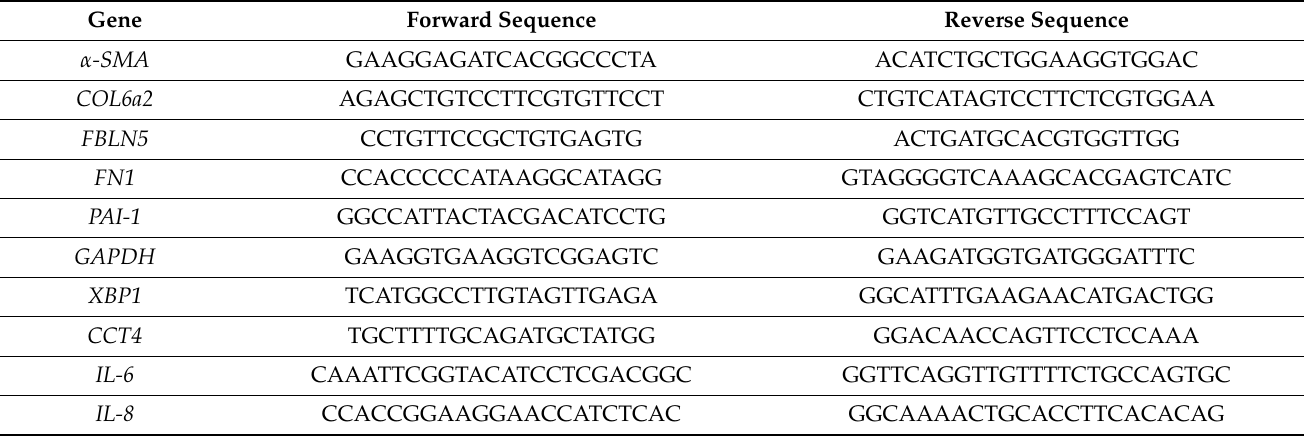
Table 1. Quantitative PCR Primer sequences